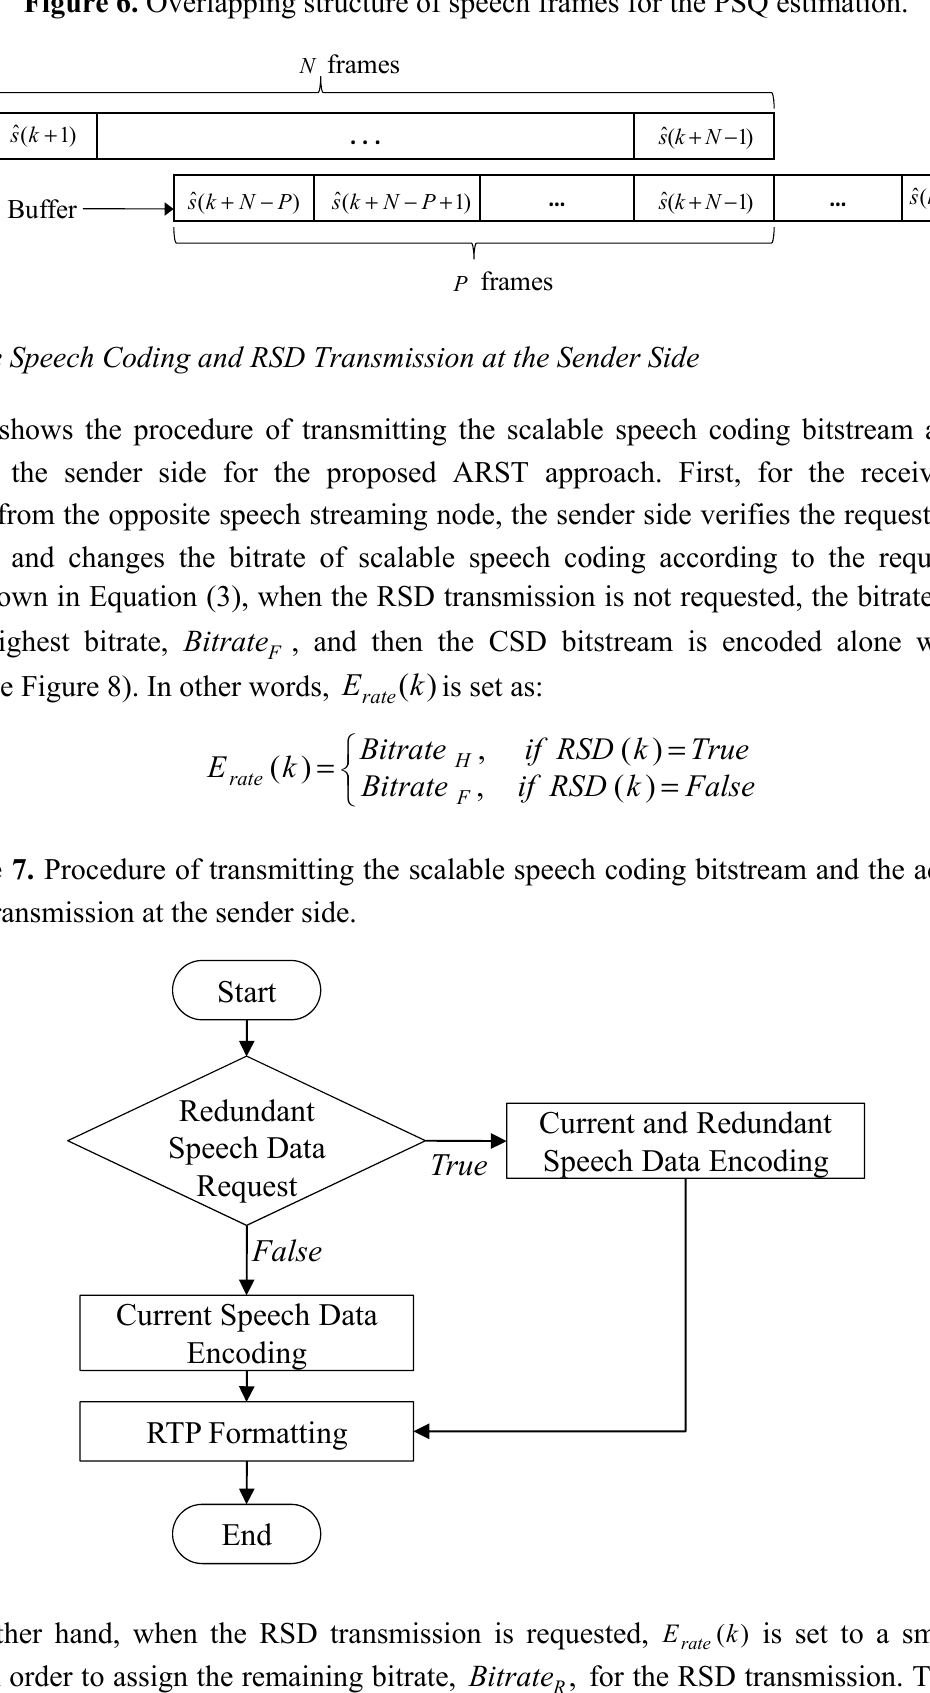
Figure 6. Overlapping structure of speech frames for the PSQ estimation.